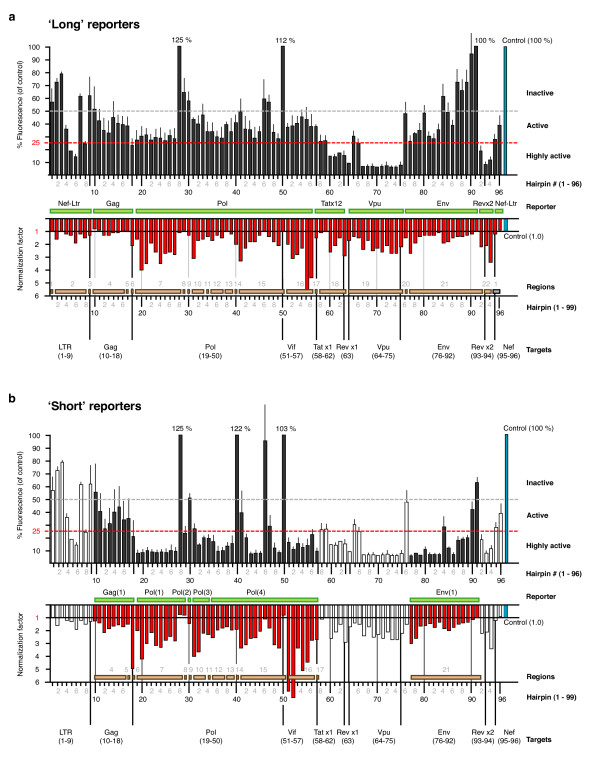
Suppressive activities measured with fluorescent reporters. Suppressive activities were screened using gene-specific fluorescent fusion reporters in a transient expression assay. The 96 hairpins were individually transfected with a target-specific GFP fusion reporter, and an AsRed-1 non-specific reporter. Specific activity is shown as percentage fluorescence of the unsuppressed control (black bars above; control shown in blue), and non-specific activity is shown as the fold difference (normalization factor) relative to the baseline non-specific activity of the unsuppressed control (red bars below, control shown in blue). E.g. a normalization factor of 1 is no non-specific activity, a value of 2 is twice as much non-specific activity of the baseline control (set at 1). Categorical markers divide the hairpins into inactive, active and highly active groups. The reporter used for each hairpin (green bars), and the 22 targeted regions (brown bars) are also shown. (a) Suppressive activities measured with the first round 'long' (core genes) and 'short' (accessory genes) reporters. (b) The previous long reporters were replaced with a series of shorter fragment reporters and suppressive activities were remeasured. The suppressive activities form the previous short accessory gene reporters are included for comparison (hollow bars).